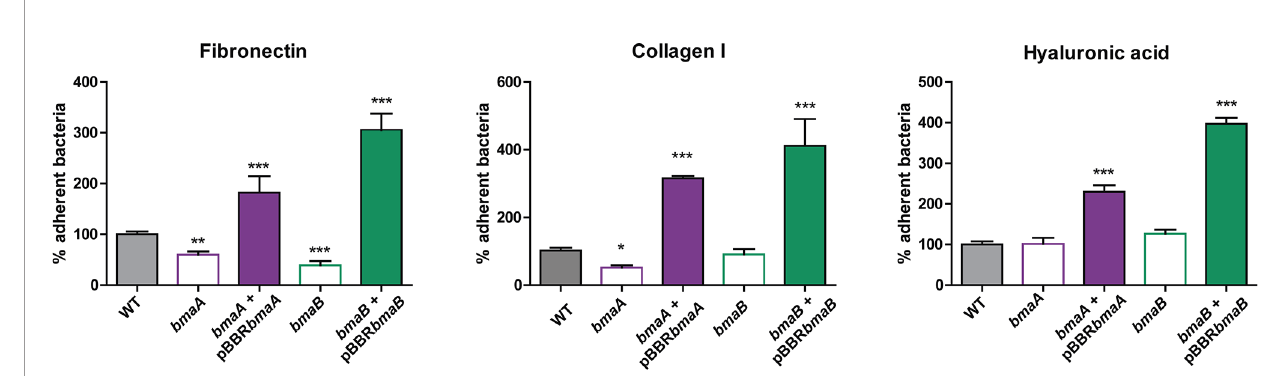
FIGURE 3 | Adherence of B. suis strains to ECM components. Binding to immobilized ligands of B. suis wild type, B. suis bmaA ::stops ( bmaA ), B. suis bmaB ::Km ( bmaB ), and the respective complemented strains ( bmaA:: st + pBBR bmaA, bmaB ::Km + pBBR bmaB and bmaC KI) was assayed. Values correspond to the percentage of binding to ECM components. A value of 100% was assigned to control strains. Data represent the means and standard deviations (SD) of the results of a representative experiment done in triplicate. Three independent experiments were performed with similar results. Data were analyzed by one-way ANOVA followed by a Tukey´s post hoc test. *, signi fi cantly different from control p < 0.05, **p < 0.005, ***p <